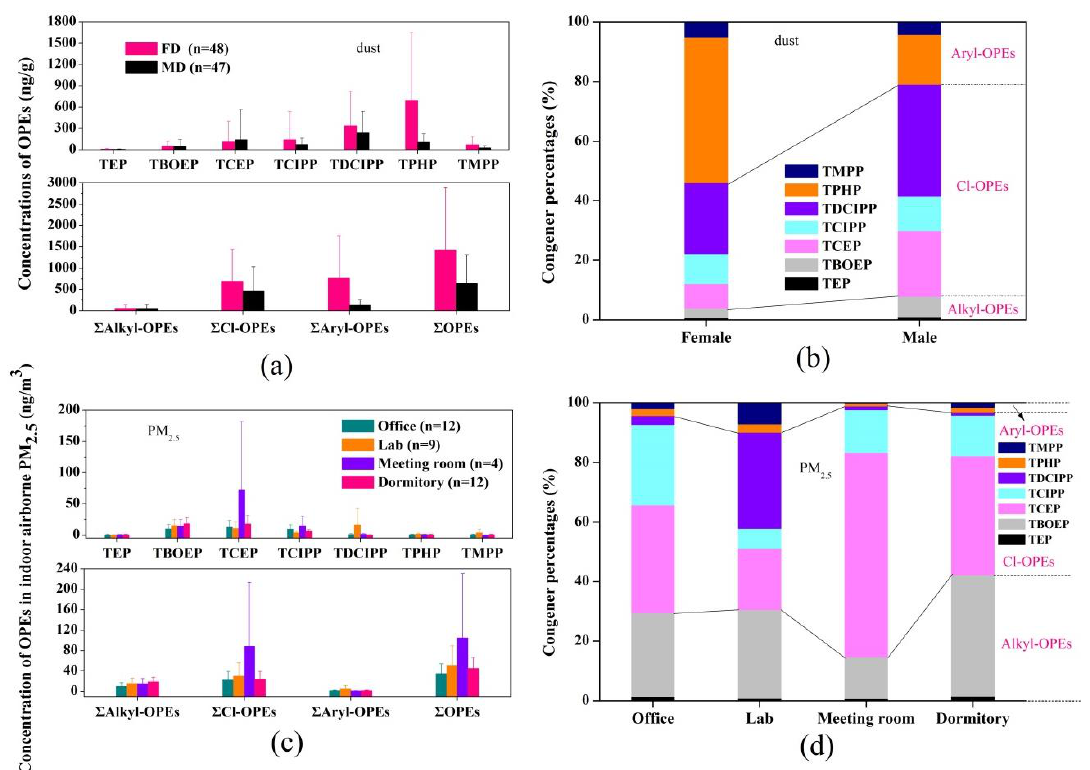
Figure 1. ( a ) Concentrations of OPEs in indoor dust samples from male dormitories (MD) and female dormitories (FD) (ng/g); ( b ) Composition of OPEs in indoor dust samples from male dormitories (MD) and female dormitories (FD) (%); ( c ) Concentrations of OPEs in indoor atmospheric PM 2.5 samples from different functional areas (ng/m 3 ); ( d ) The composition of OPEs in indoor atmospheric PM 2.5 samples from different functional areas (%).